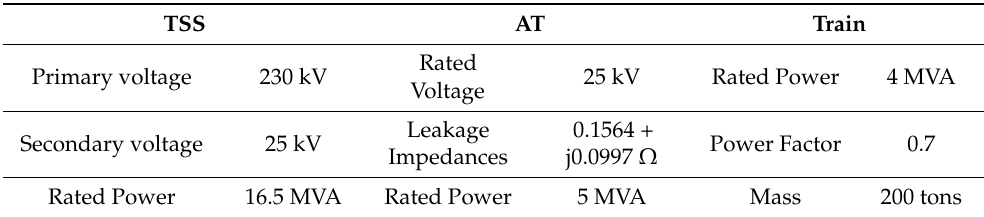
Table 1. Specifications of the traction substation, autotransformer, and the trains in the simulation. TSS AT Train